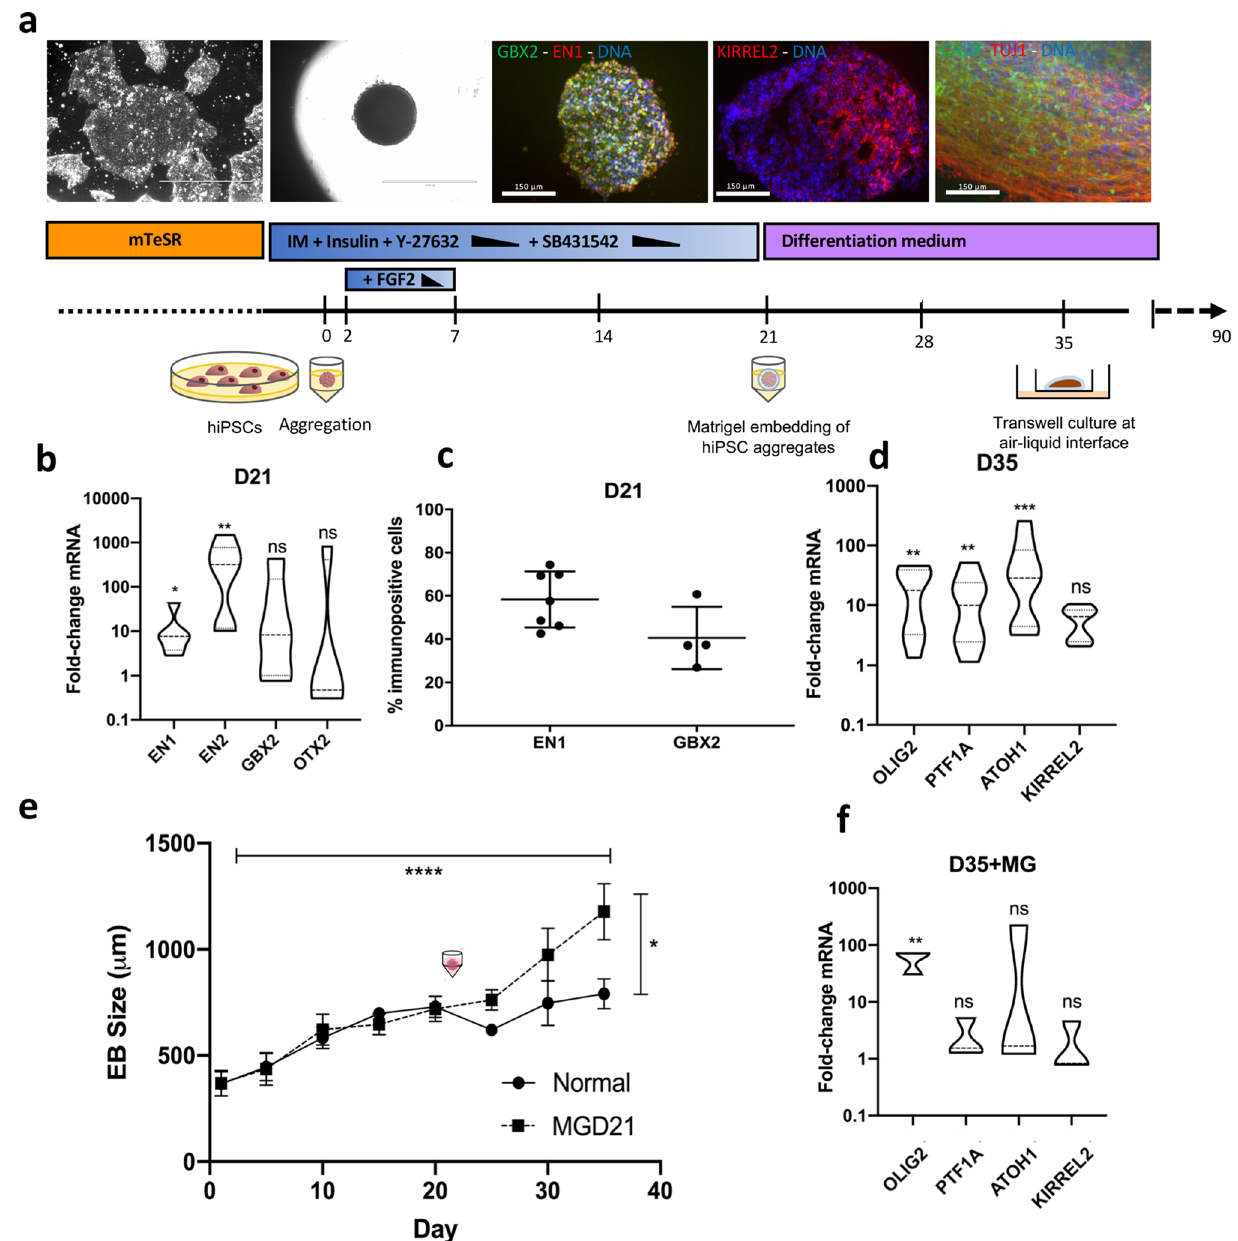
Figure 1. Cerebellar differentiation protocol recapitulating MHB formation and subsequent RL/VZ expansion. ( a ) Overview of cerebellar differentiation protocol. Representative images of key stages are shown above (from left to right); undifferentiated iPSCs, day 21 EBs, day 21 EB cryosections immunostained for GBX2 (green) and EN1 (red), with nuclear Hoechst staining (blue), Day 35 organoid cryosections immunostained for KIRREL2 (red), with nuclear Hoechst staining (blue), and Day 60 organoids immunostained for Calbindin (green), TUJ1 (red), with nuclear Hoechst staining (blue). Scale bars are 1000 μm (first two panels) and 150 μm (all other panels). ( b ) mRNA levels of day 21 EBs displayed as fold-change values relative to undifferentiated iPSCs. Samples were calibrated relative to ACTB . EN1 (p-value 0.0346), GBX2 (p-value 0.1147), EN2 (p-value 0.0087) and OTX2 (p-value 0.6429). Results are shown from 5–6 independent differentiation experiments, Mann–Whitney test. ( c ) Quantification of EN1 or GBX2 (single- channel stain) immunostaining in day 21 EB cryosections as assessed by percentage of immunoreactive nuclei divided by total nuclei. Graphs show mean with SD from 4–7 independent differentiation experiments. ( d ) Day 35 mRNA levels of OLIG2 (p-value 0.0023), PTF1A (p-value 0.0072), ATOH1 (p-value 0.0004), and KIRREL2 (p-value 0.4211). Violin plots show median and interquartile range. Data is shown from 8–9 independent differentiation experiments tested for significance using unpaired Mann–Whitney test. ( e ) Growth rate of organoids was significant over the course of differentiation (p-value 0.0001) and significantly increased by the addition of Matrigel (MG) from day 21 onwards (p-value 0.0101) as assessed by two-way ANOVA, Dunnet multiple comparison test. Error-bars represent mean/SEM. ( f ) Matrigel encapsulation resulted in a significant increase in OLIG2 mRNA (p-value 0.0044), but non-significant changes in PTF1A (p-value 0.0857), ATOH1 (p-value 0.2527) and KIRREL2 (p-value 0.4893). Results are shown from three differentiation experiments, unpaired Mann–Whitney